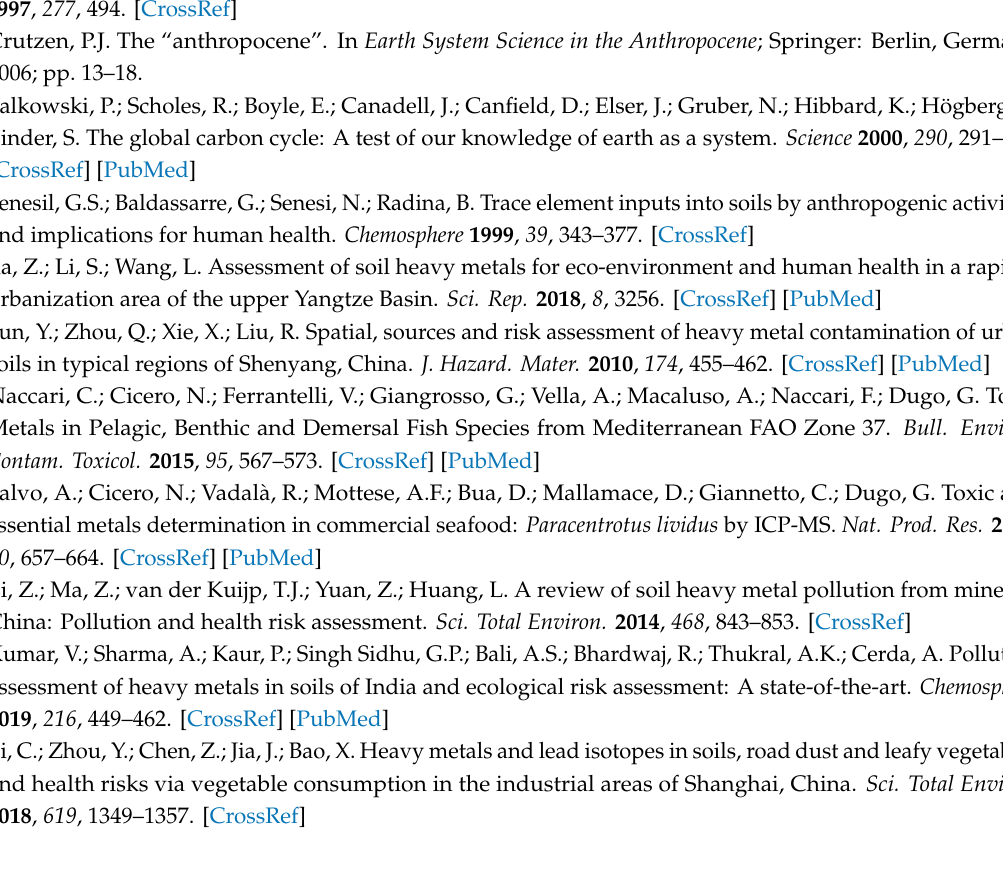
Table S1: Total variance explained for potentially toxic elements with Principal Component Analysis; Table S2: The detailed parameters for geographically weighted regression in Table 2; Figure S1: Residuals normality test of the residuals for the fitting results of potentially toxic elements (As, Cd, Sb, and Hg) with geographically weighted regression and classical linear